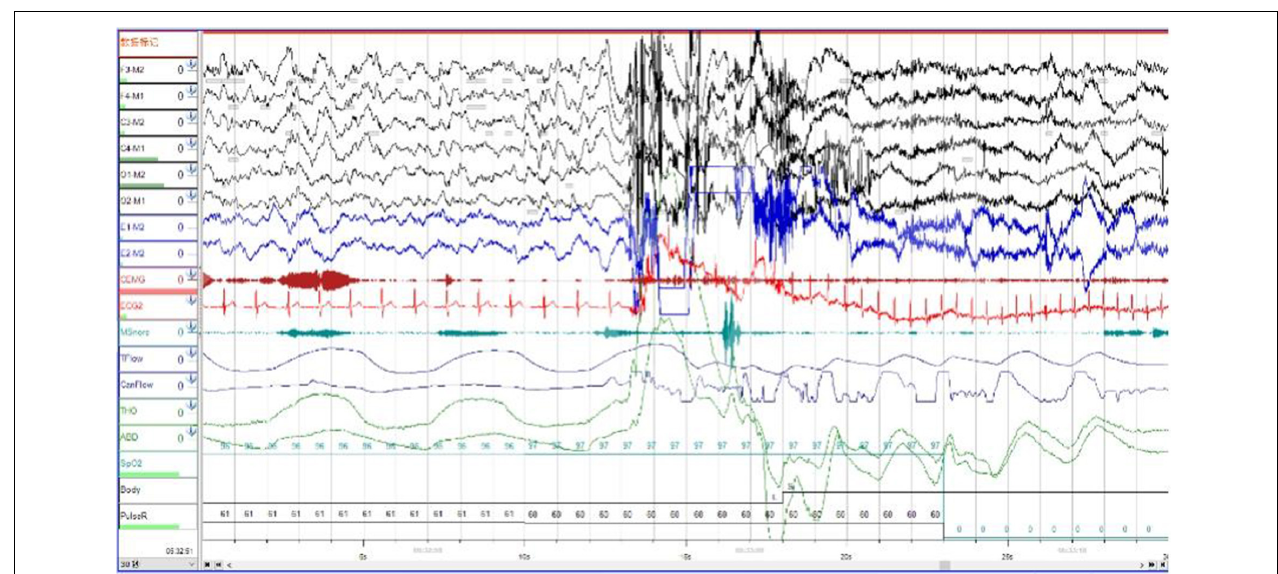
FIGURE 3 | The patient’s heart rate rapidly increased from 60 to 105 beats/min with the increase in breathing rate. Brain wave changes from delta to alpha